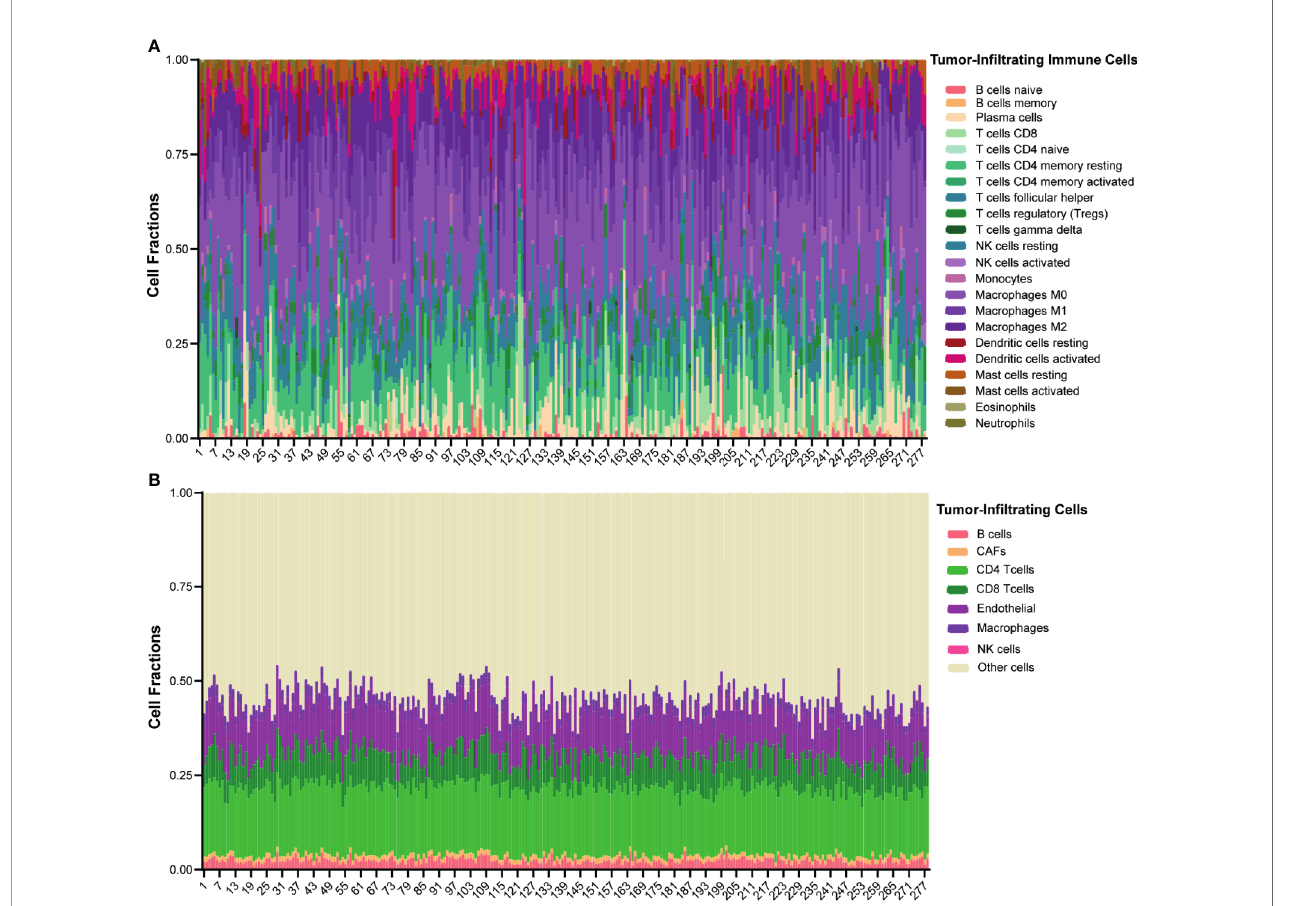
FIGURE 1 | The landscape of immune in fi ltration of 278 OSCC patients in TCGA cohort. (A) Heatmap of 22 types of tumor-in fi ltrating immune cells deconvolved using CIBERSORT in OSCC. (B) Heatmap of 7 types of tumor-in fi ltrating cells deconvolved using EPIC in